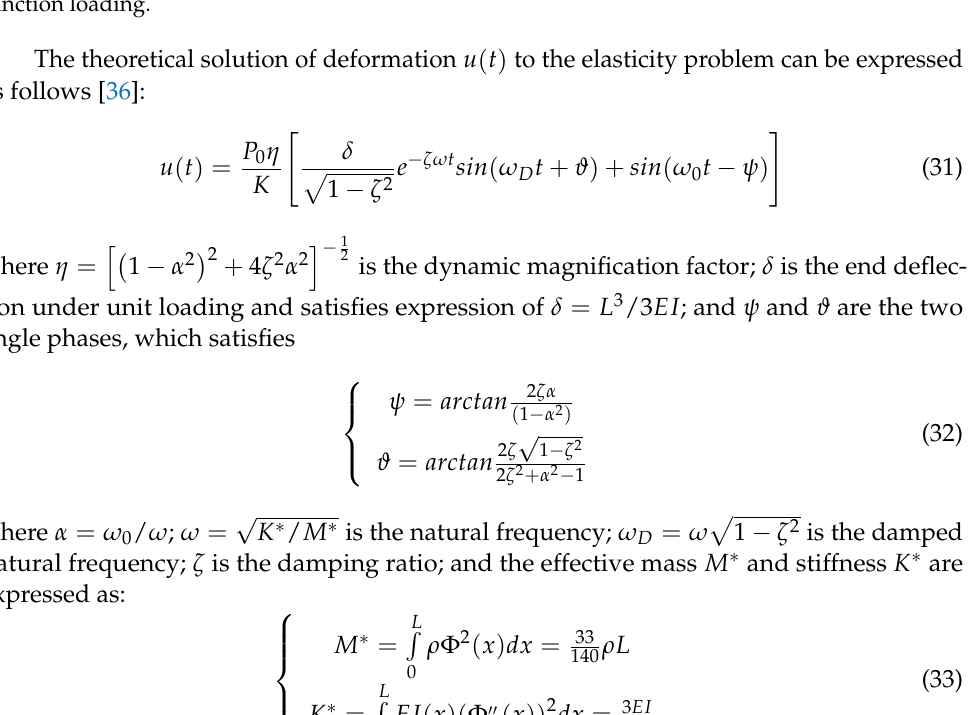
Figure 8. Descriptions of an elastic bar problem: ( a ) geometry of the elastic bar; ( b ) applied harmonic function loading.